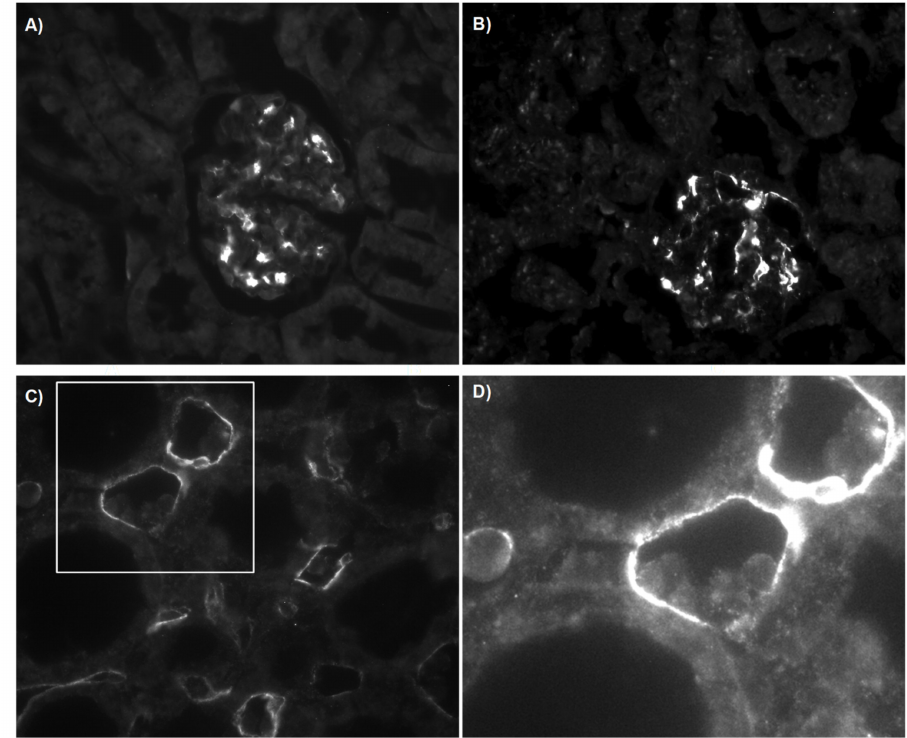
Figure 4. Representative immunohistochemical staining for C4d. Cryosections from CTR ( A ), sTX ( B ), and aTX ( C ) kidneys were stained using an antibody directed against C4d. After incubation with an Alexa488 labelled secondary antibody, signals were visualised by an epifluorescence microscope. Positive C4d staining was observed in the glomeruli of CTR and sTX kidneys ( A , B ). Additional staining was only observed after allogeneic transplantation ( C ). Magnification of the marked area from C shows that cells were attached at C4d-positive sites ( D